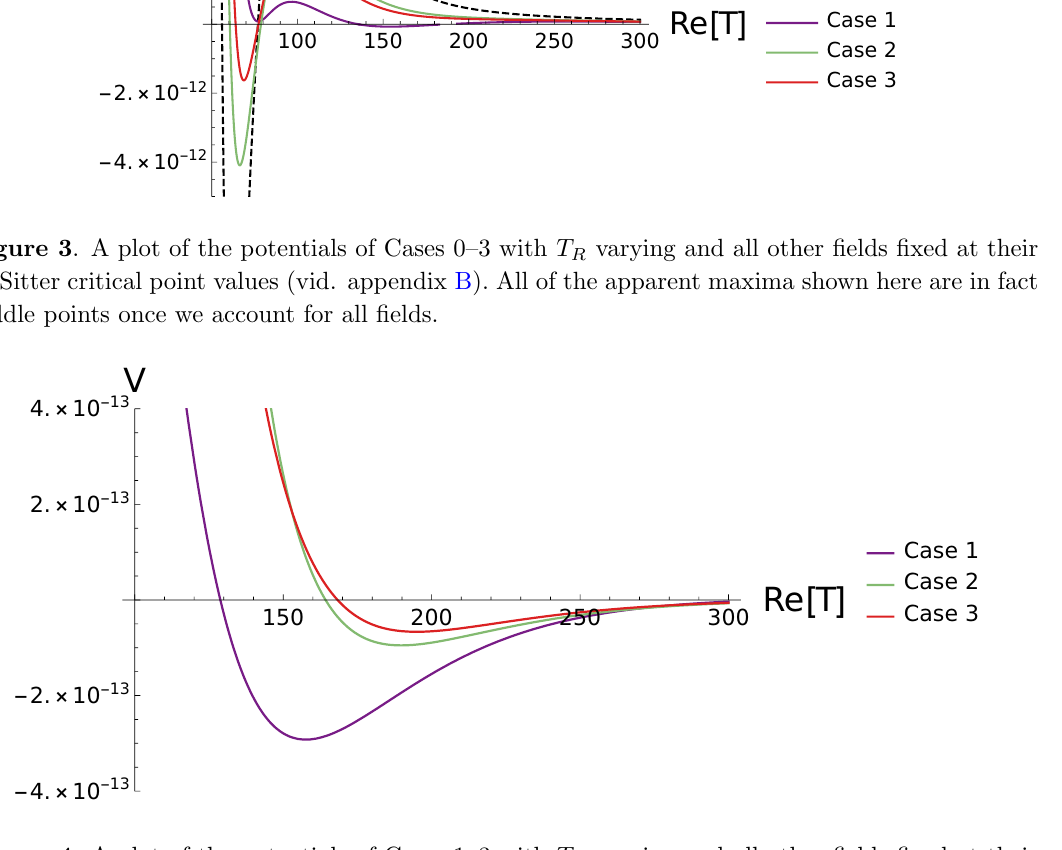
Figure 4 . A plot of the potentials of Cases 1{3 with T R varying and all other (cid:12)elds (cid:12)xed at their second anti-de Sitter critical point values (vid. appendix B). All cases are true minima once we account for all the